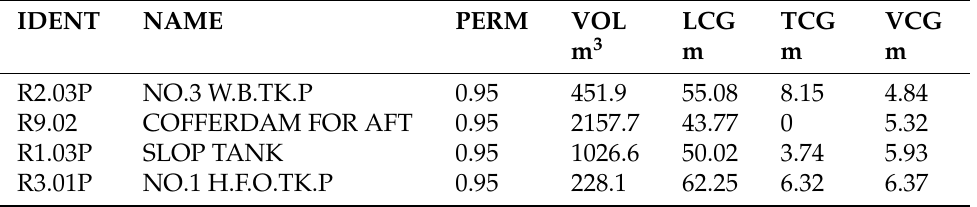
Table 8. Damaged compartments of